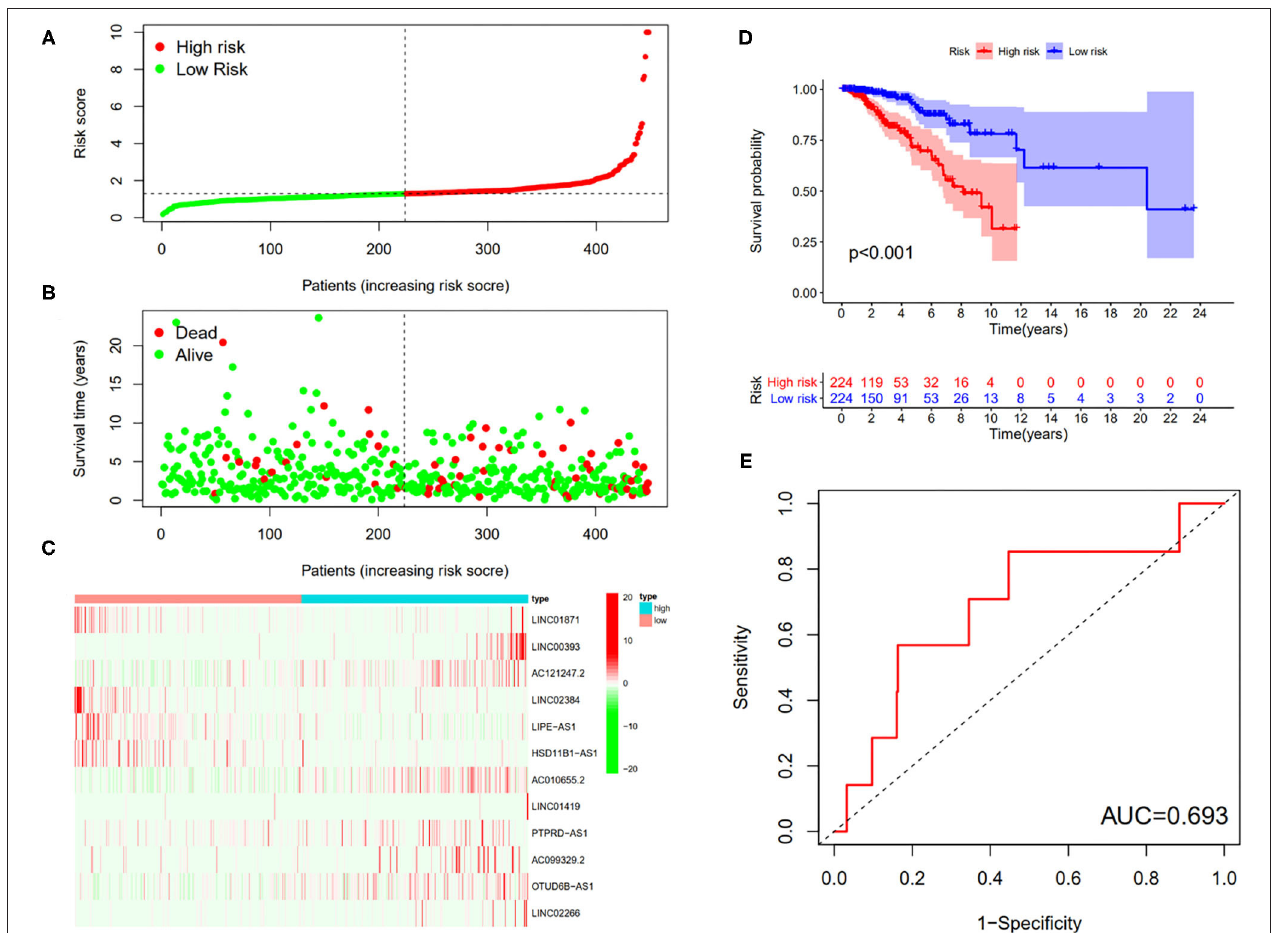
FIGURE 9 | The 12-LncRNA signature in the training set. (A) The distribution of risk score; (B) the survival time and status of patients; (C) the bottom shows the heatmap of 12-LncRNA expression profile. Colors from red to green indicate decreasing expression level from high to low; (D) the K–M curves for high- and low-risk groups. Purple color represents the low-risk group, whereas red color represents the high-risk group; (E) receiver operator characteristic (ROC) curves for patients with BC in testing set. AUC, area under the